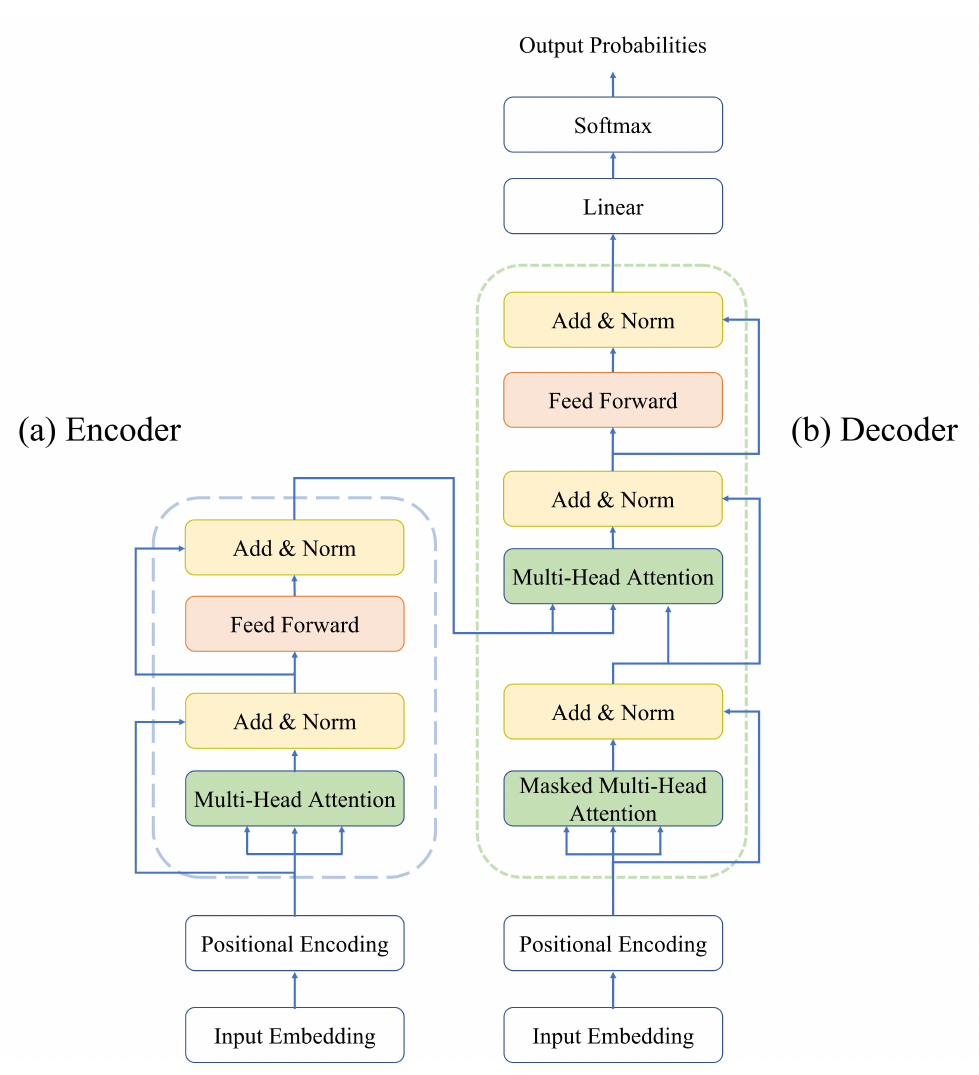
Figure 2. The architecture of the vanilla